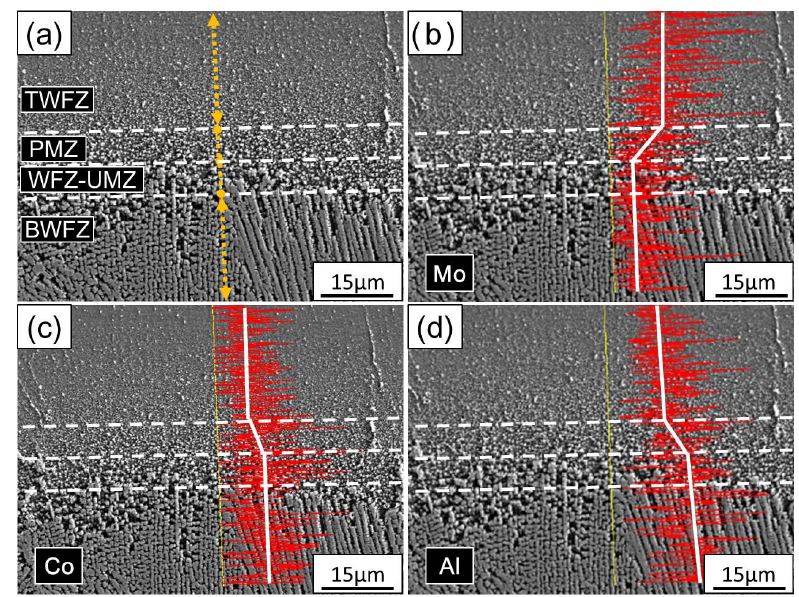
Figure 5. ( a ) EDS line scan across the various regions in WFZ, with composition profiles including ( b ) Mo, ( c ) Co, and ( d ) Al.